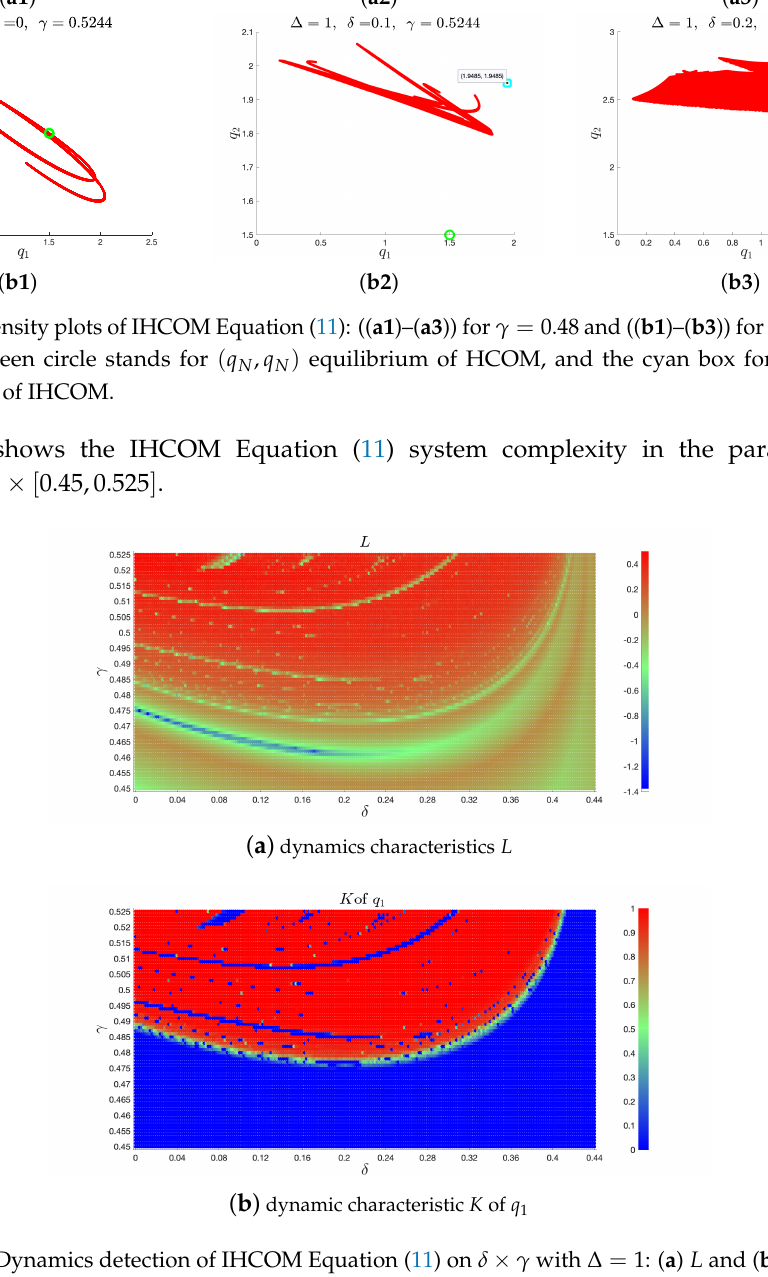
Figure 7. Dynamics detection of IHCOM Equation (11) on δ × γ with ∆ = 1: ( a ) L and ( b ) K of q 1